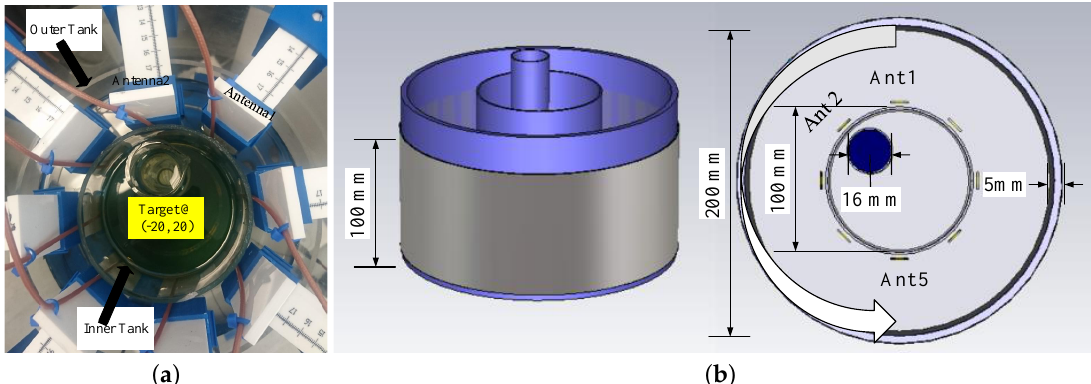
Figure 4. ( a ) Photo of the hardware system prototype used in our measurements; ( b ) Schematic of the imaging system hardware modelled in